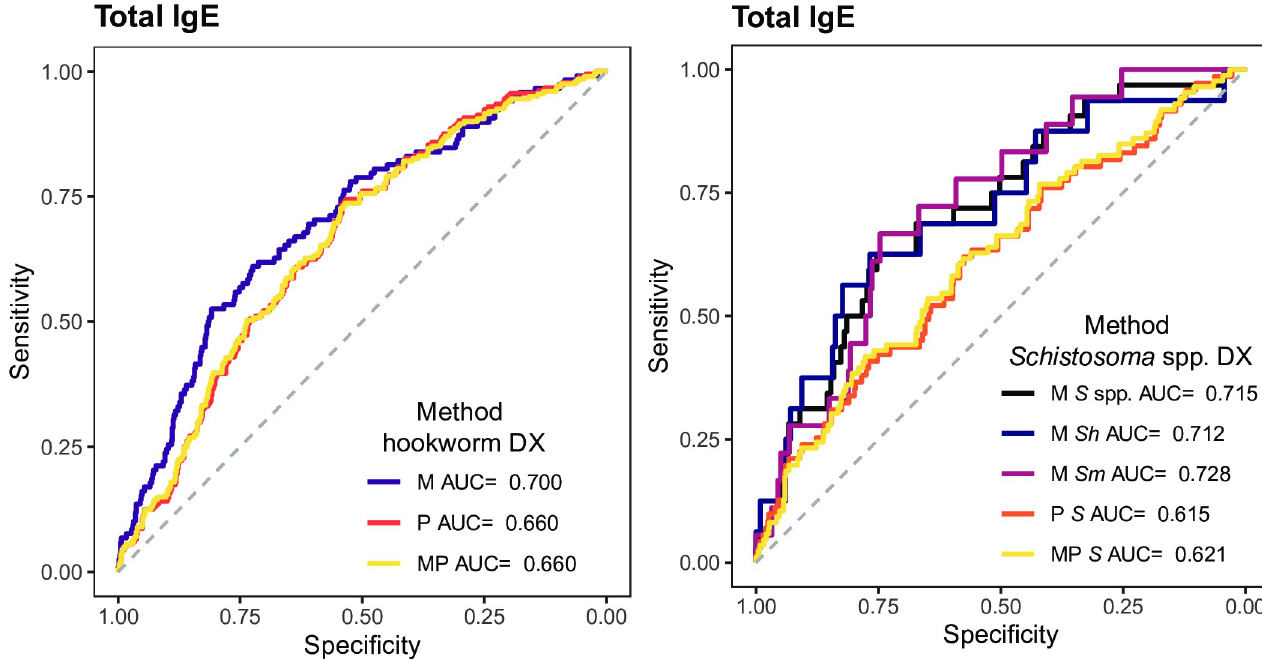
Fig 5. Receiver operating characteristic curves and their corresponding areas under the curve from the best performing total IgE responses in detecting current hookworm and Schistosoma spp. infection. Total IgE responses (log 10 -transformed median fluorescence intensity levels) in serum samples from 715 endemic individuals were used as predictor variable. Microscopic (M), qPCR (P) or the combination of both (MP) diagnoses for hookworm and Schistosoma spp. were used as response variables. DX: diagnosis; S spp.: Schistosoma spp.; Sh : Schistosoma haematobium ; Sm : Schistosoma mansoni ; AUC: Area Under the